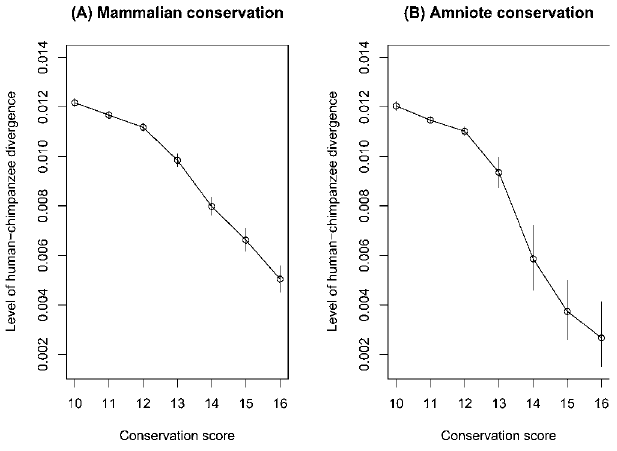
Figure 1. Levels of Human–Chimpanzee Divergence for Different Conservation Scores Conservation scores are calculated using either human–mouse–dog three-way comparisons (A) or human–mouse–chicken comparisons (B). Error bars represent 95% confidence intervals. DOI: 10.1371/journal.pcbi.0010073.g001 PLoS Computational Biology |